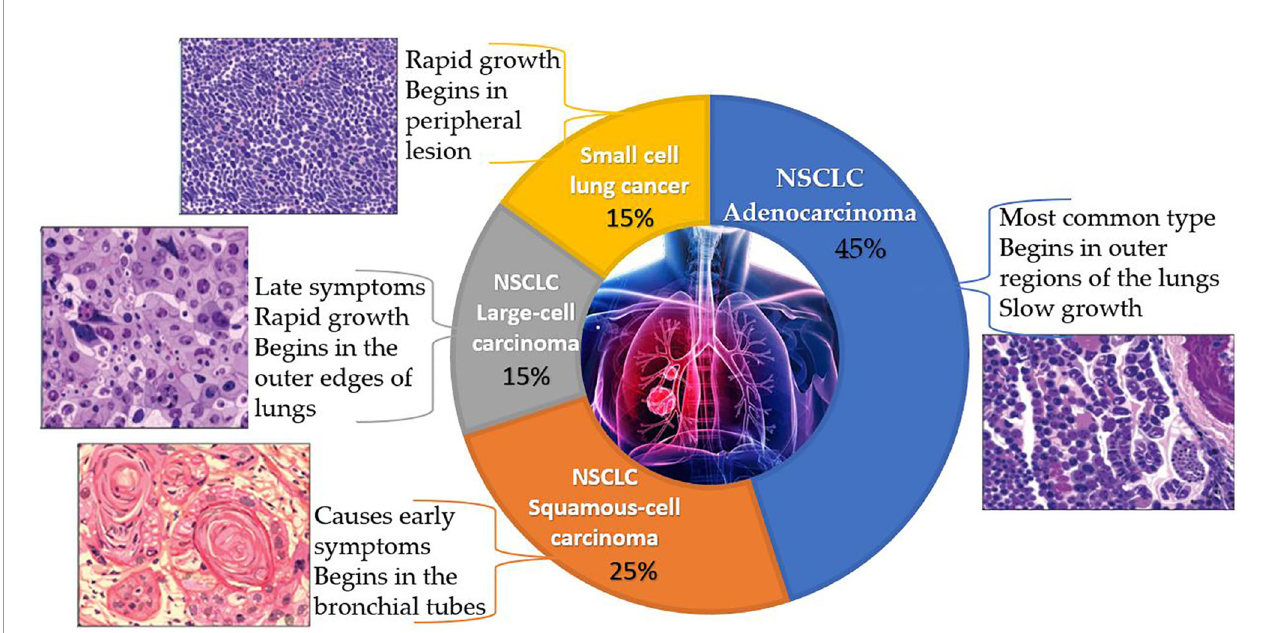
FIGURE 1 | A pie chart representing the classi fi cation of lung cancer along with the characteristics, origin and histopathology of each type. (The above histopathology pictures were retrieved from https://www.lungevity.org/).